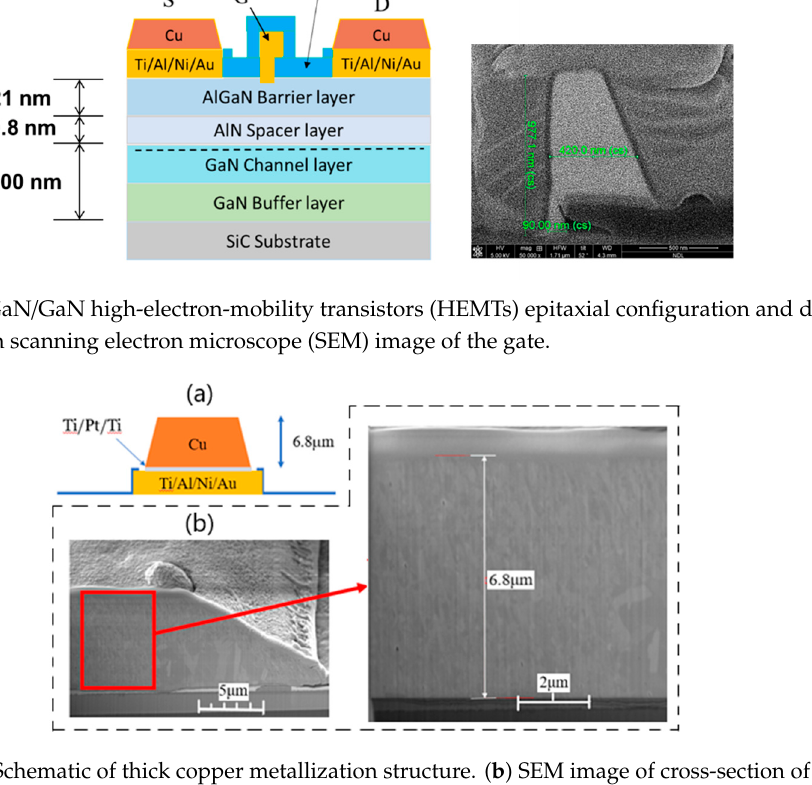
Figure 2. ( a ) Schematic of thick copper metallization structure. ( b ) SEM image of cross-section of thick copper metallization for GaN HEMT.